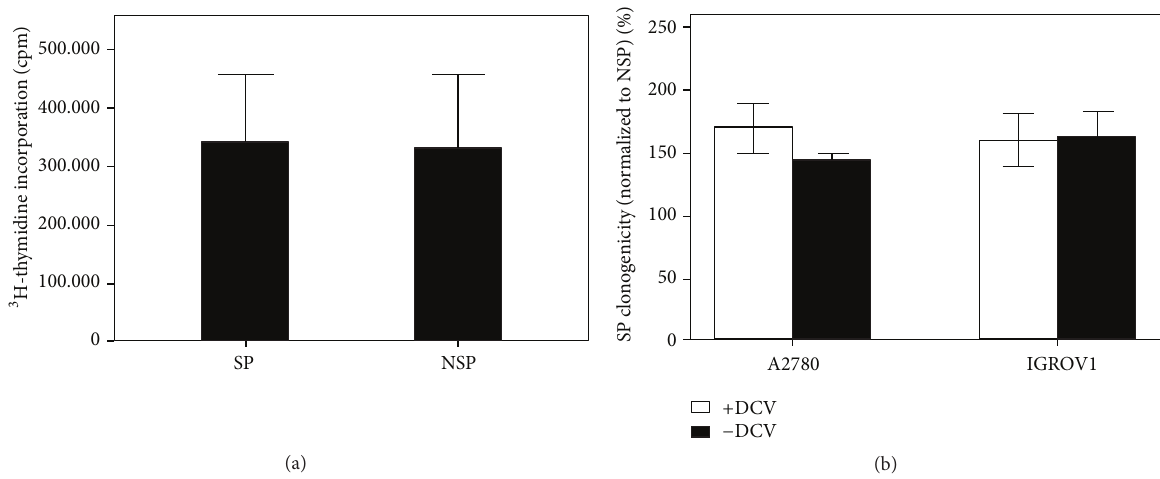
Figure 6: DCV does not impinge on cell proliferation or single cell clonogenicity. (a) A2780V cells were stained with 10 𝜇 M DCV (10 6